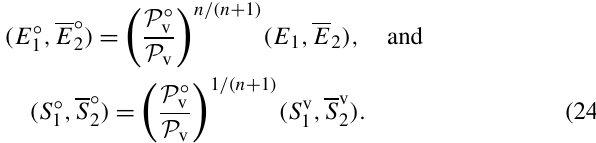
iso-mechanical dissipation points in the plane ( S 1 / 3 ,S 2 ) can be recovered thanks to the homogeneity property (Eq.